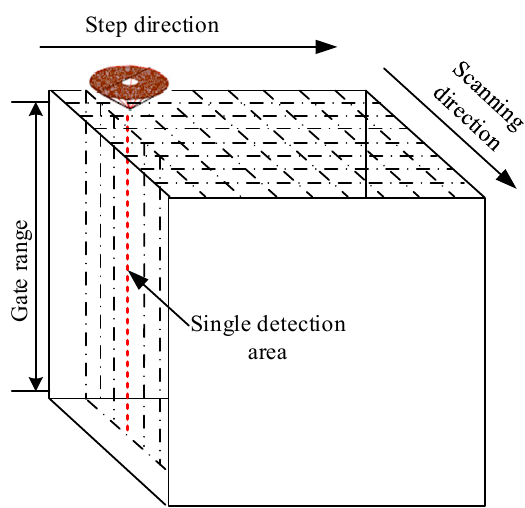
Figure 7. Schematic of the total focusing method (TFM) C-scan inspection using the annular array Figure7. Schematicofthetotalfocusingmethod(TFM)C-scaninspectionusingtheannulararraytransducer. transducer.